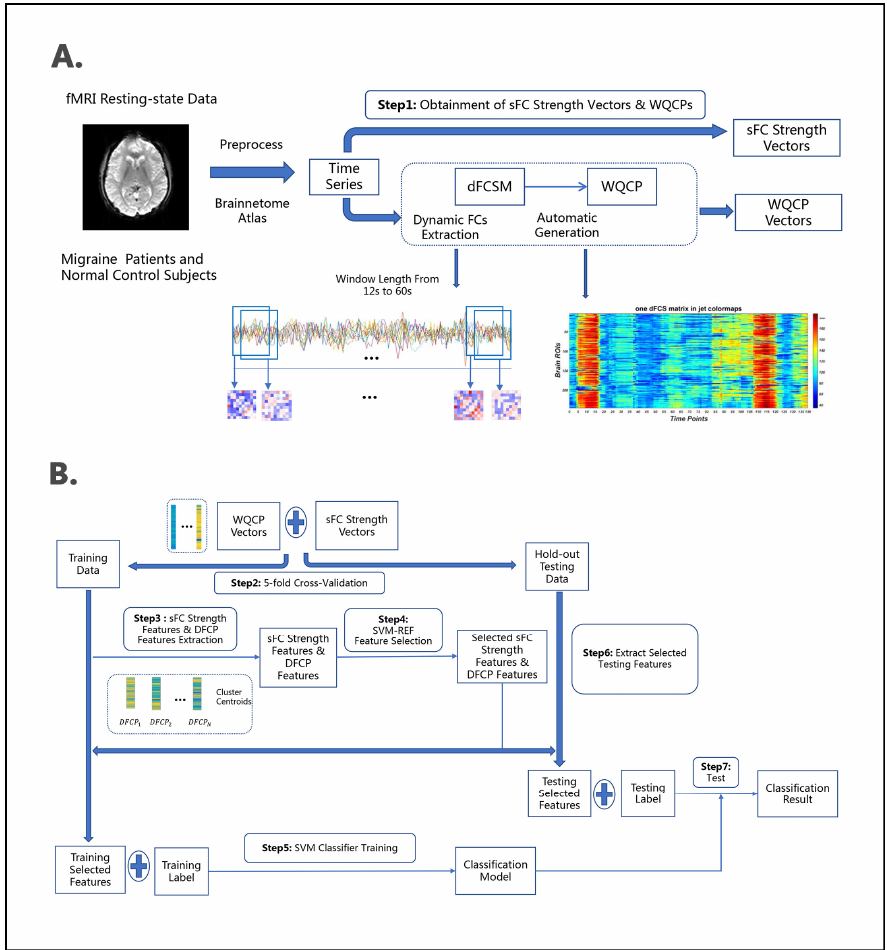
Figure 3. The framework of the classification approach based on combined sFC strength and DFCP methods. ( A ) The preprocessed fMRI resting-state data were decomposed into 246 regions of interest (ROIs) by Brainnetome Atlas. sFC strength vectors were obtained from the resting-state FC between the ROIs as mentioned in Algorithm 1. The WQCP vectors were automatically generated as mentioned in Algorithm 2. ( B ) The DFCP features were obtained based on WQCP vectors as mentioned in Algorithm 2. The sFC strength features and DFCP features were sent into the feature selection and classification framework, which were performed on the basis of 5-fold cross-validation strategy. Both